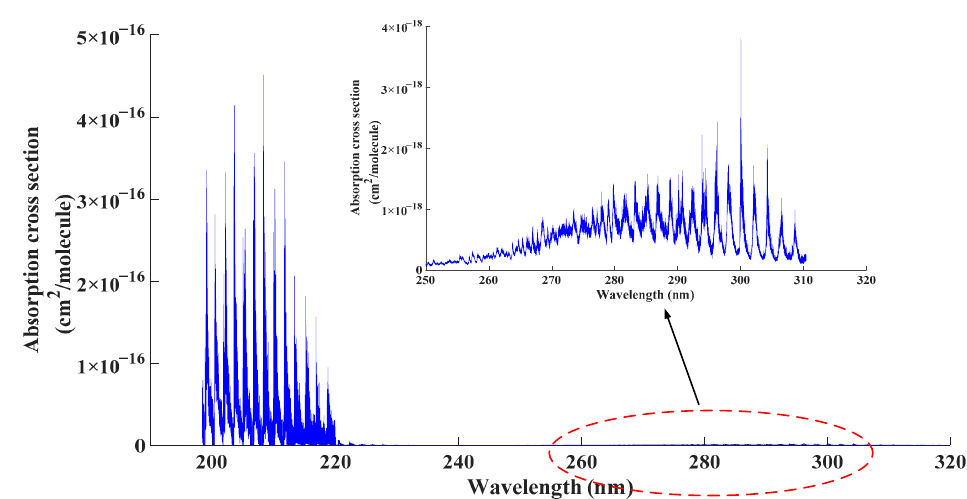
Figure 1. Absorption cross section of SO 2 in UV range.